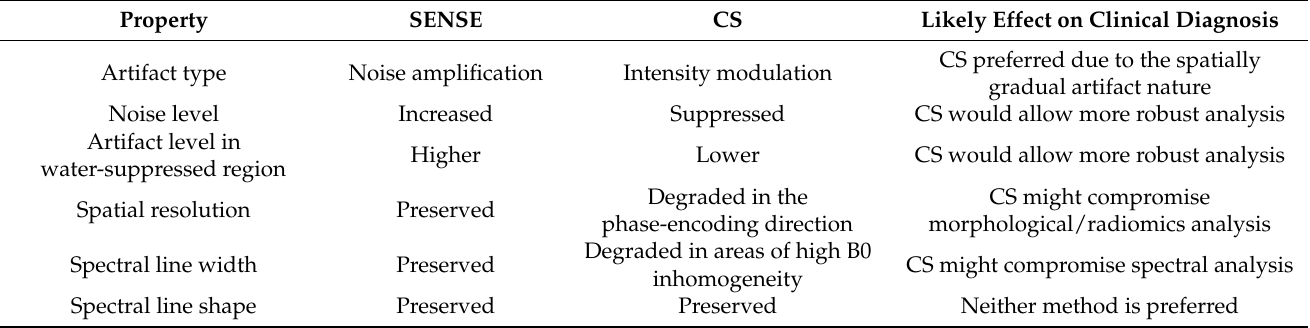
Table 1. Comparison of SENSE vs. CS properties under increasing acceleration